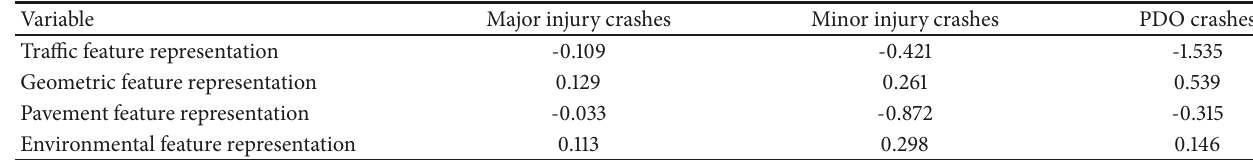
Table 5: The functional network between the feature representation and different crash